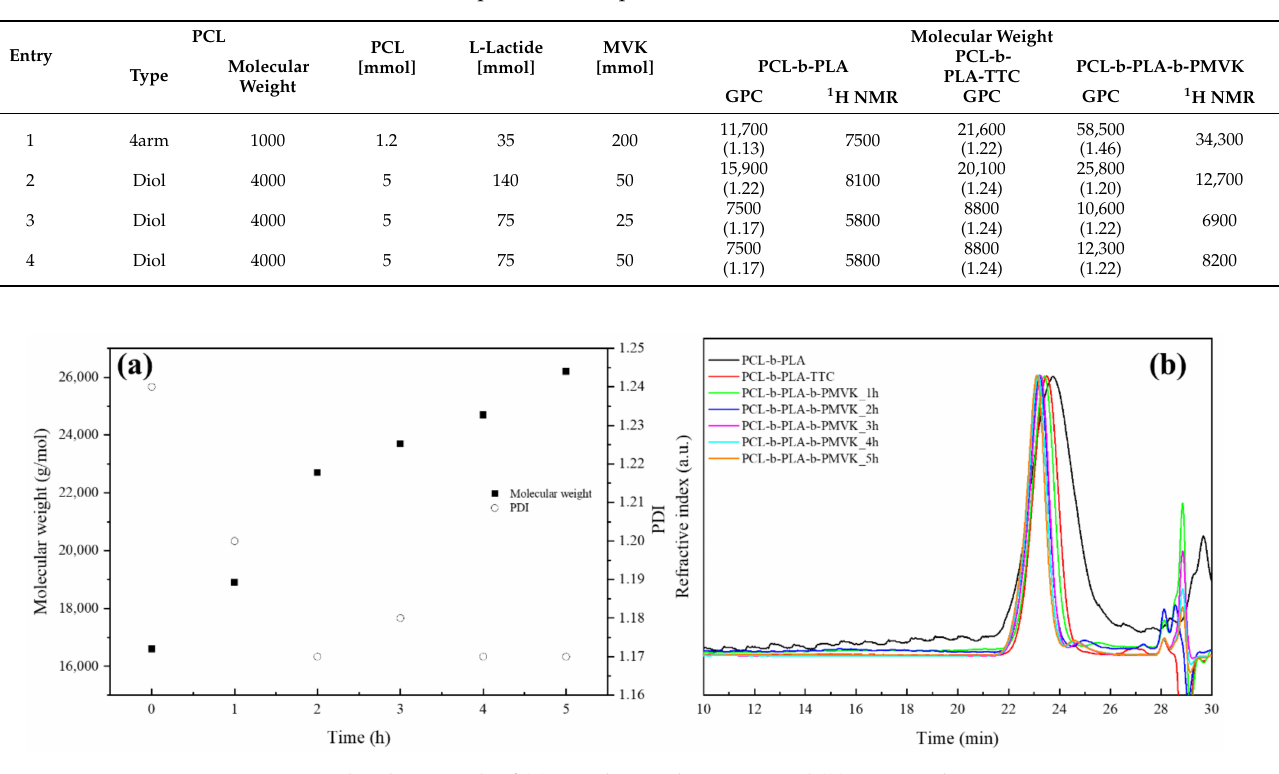
Figure 3. Molecular growth of ( a ) PCL-b-PLA-b-PMVK, and ( b ) its GPC